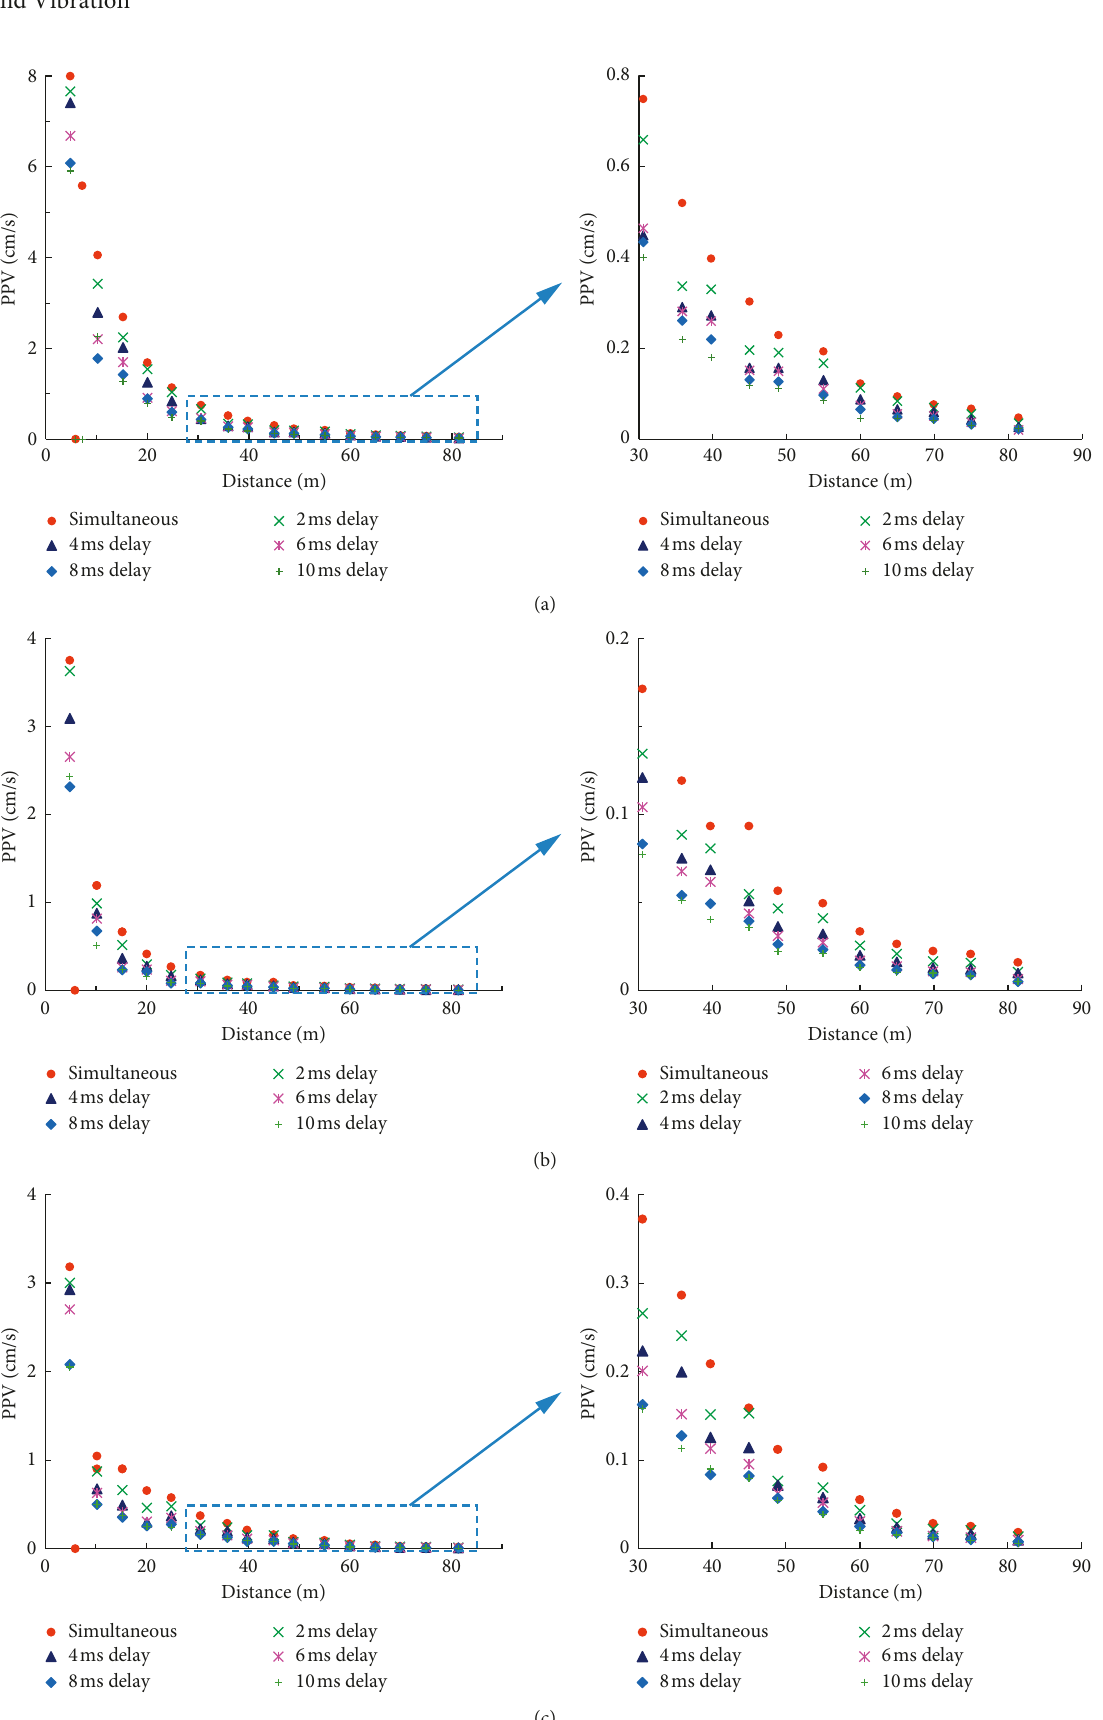
Figure 15: Simulated PPV at recording points along the monitoring line for different delay intervals. (a) X direction. (b) Y direction. (c) Z